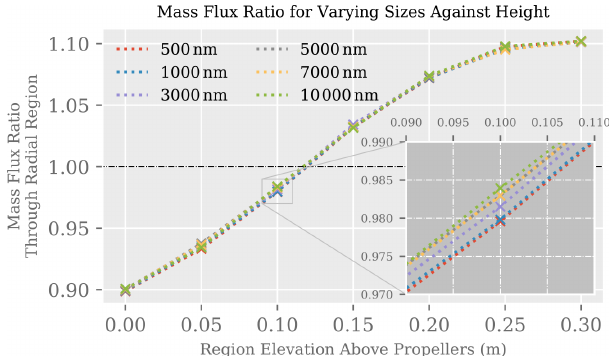
Figure 9. CFD–LPT results for the ratio of particle mass flux at the top of the domain to particle mass flux through planes with varying z coordinates. Each line represents the mass flux for a different size particle described in the key. The annular region for this plot has a lower radius of 0.15m and an upper radius of